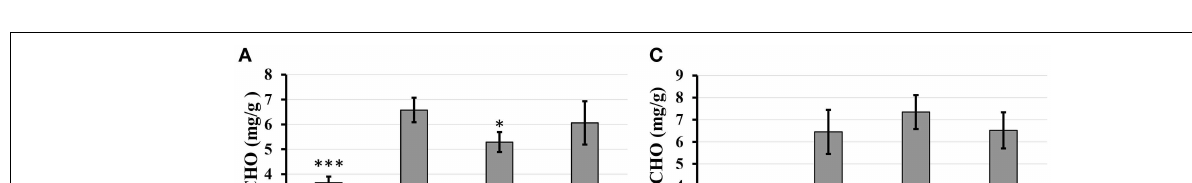
NCD: normal diet; HCD: high-cholesterol diet; HCD-KID7: HCD + P. pentosaceus KID7; HCD- L.ac : HCD + L. acidophilus . Data are expressed as means ± SEM ( n = 8 /group). * , *** indicate significantly lower at P < 0 . 05 and P < 0 . 005 , respectively, vs. the HCD group.